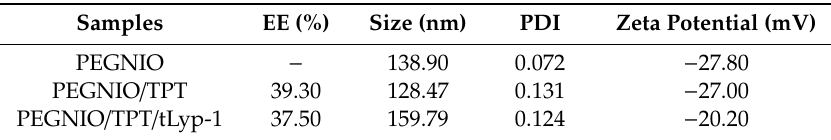
Figure 1. Hydrodynamic diameter ( A ) and PDI ( B ) of the topotecan (TPT)-loaded niosomes prepared using different organic: aqueous flow rate ratios (1:1; 1:2; 1:3; 1:5). Table 1. Characterization of niosomal formulations.